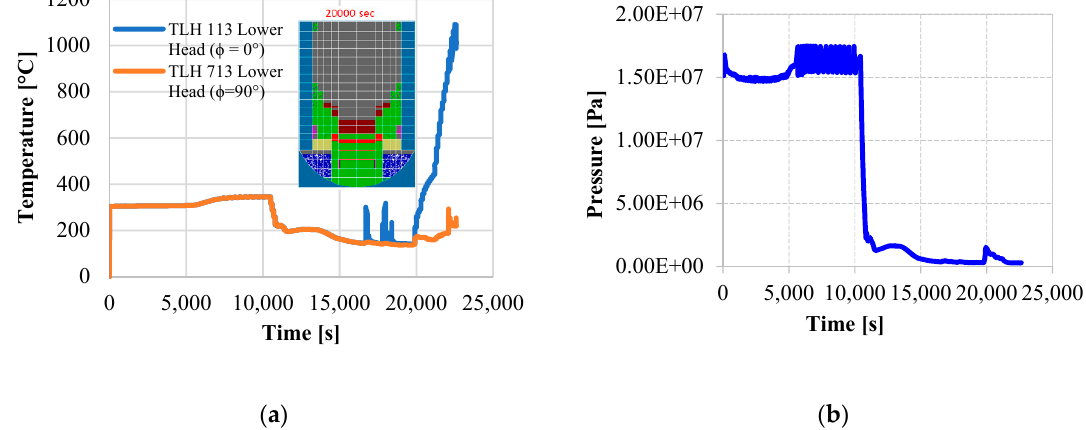
Figure 5. Plots of temperature ( a ) and pressure ( b ) in the lower plenum. In figure ( a ) the label TLH-ijj refers to the node jj of the segment i, where jj = 13 is the RPV inner surface; i = 1 and i = 7 are the first and last segment of the lower head, respectively, according to the azimuthal angular direction [4].